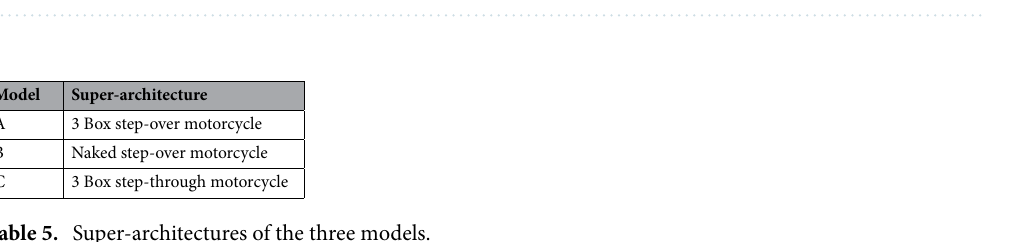
Table 4. Unique characteristics of multi-tiered architecture.